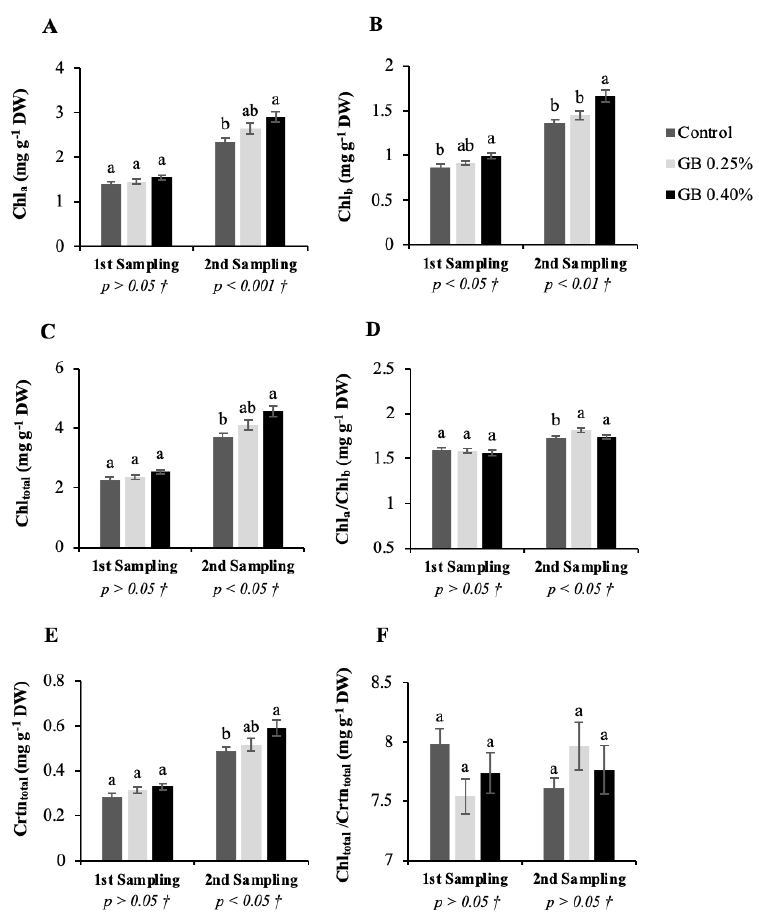
Figure 4. Represents photosynthetic pigments in sweet cherry tree leaves. Chlorophyll a (Chl a ) ( A ), chlorophyll b (Chl b ) ( B ), total chlorophyll (Chl total ) ( C ), Chl a /Chl b ( D ), total carotenoids (Crtn total ) ( E ), Chl total/ Crtn total ( F ), for the cv. Lapins leaves subjected to the different treatments. † Indicates that the p values were calculated from the one-way ANOVA analysis after verifying the assumptions of normality and homogeneity of variances. When a significant effect was observed ( p < 0.05), Tukey’s post-hoc test was applied.